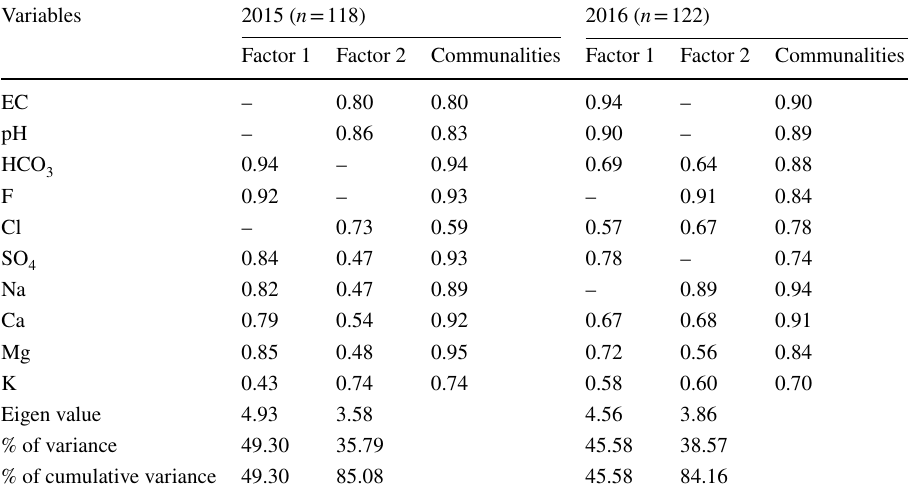
Table 9 Factor analysis of the Chaturangi glacier metlwater samples collected during the ablation period 2015 and